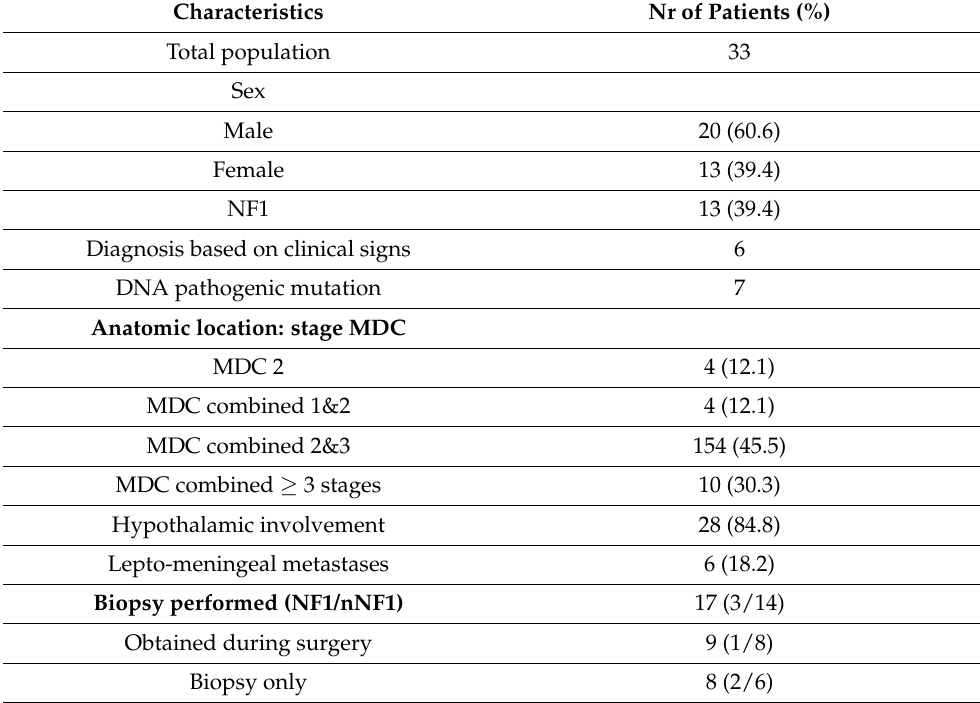
Table 1. Baseline characteristics of pediatric patients with OPG at start of treatment with BVZ.